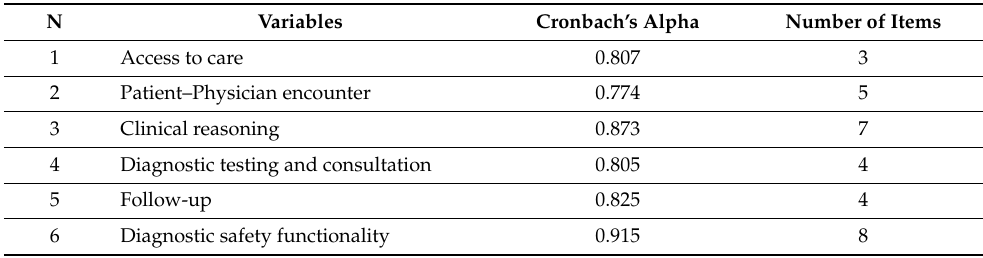
Table 2. The coefficient value of Cronbach’s